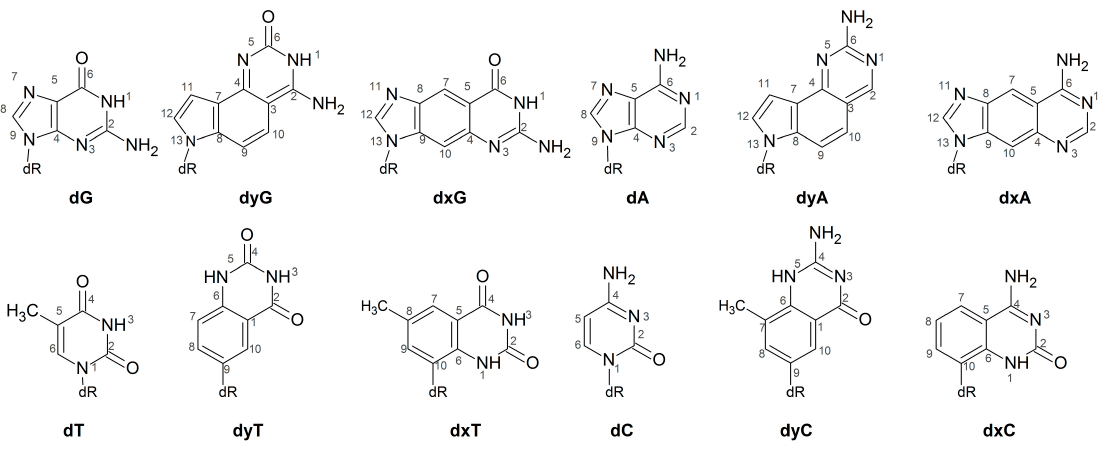
Figure 1. Chemical structures of the DNA, xDNA and yDNA bases considered in the current study.